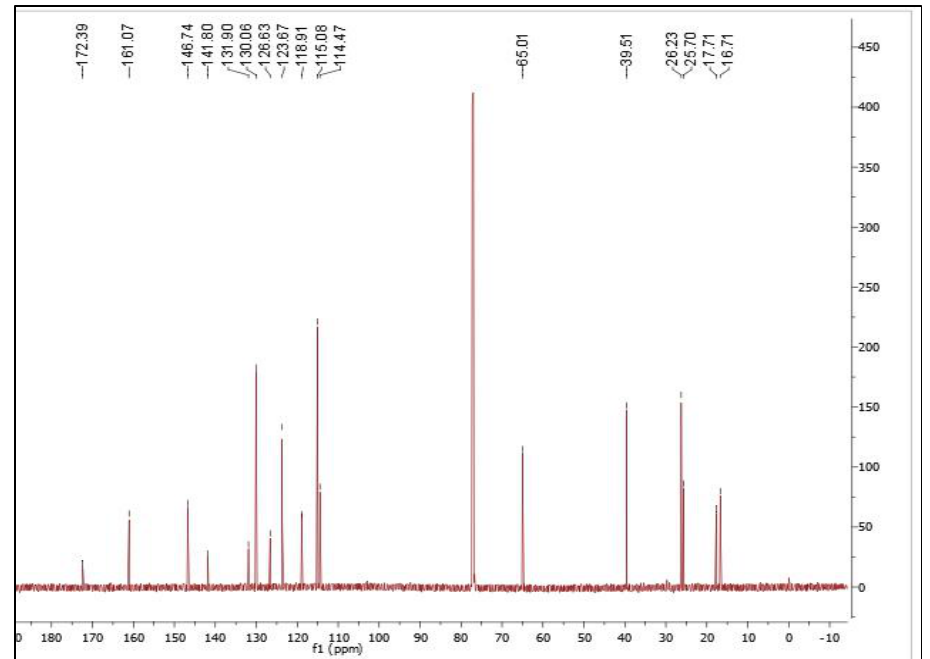
Figure 1. 1 H NMR spectrum of 7-geranyloxycinnamic acid .